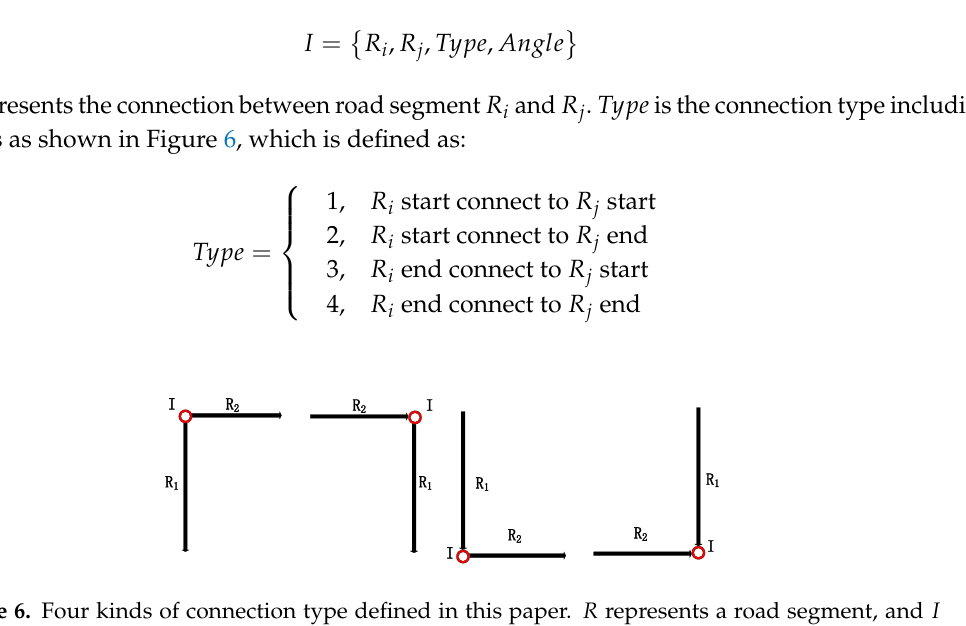
Figure 5. The indoor map is handled as a pathway graph in this paper: ( a ) a floor plan of an underground parking, the blue line is the pathway; ( b ) pathway graph of the left floor plan, the edges represent roads and the vertexes represent connections between roads.